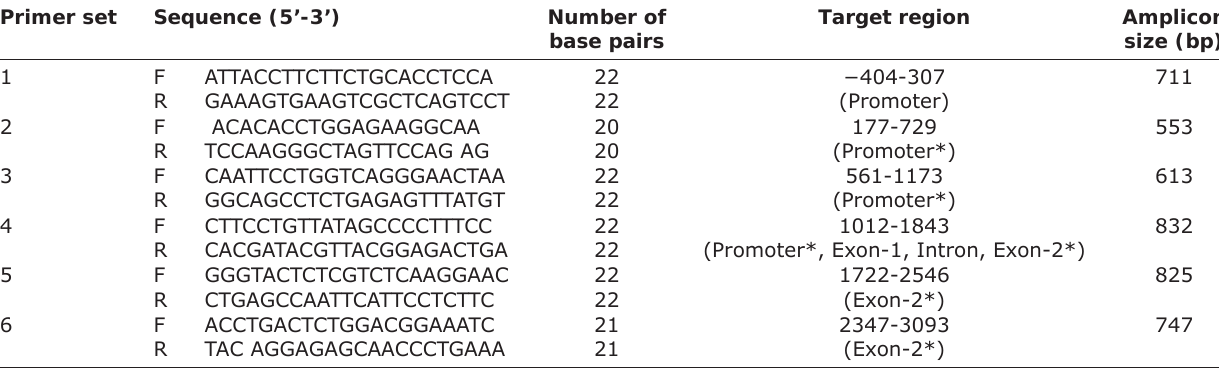
Table-1: Sequence of the primers referred for amplification of complete CD14 gene in KF cattle. Primer